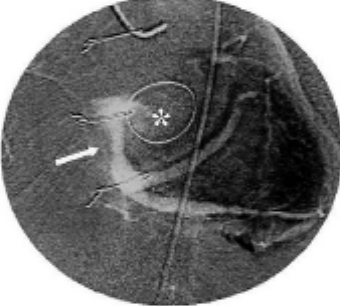
Fig. 1 – Venous phase of selective left coronary arteriography showing the contrasted coronary venous sinus. The arrow denotes an acceptable narrowing in the venous repair site and the asterisk denotes the mitral ring